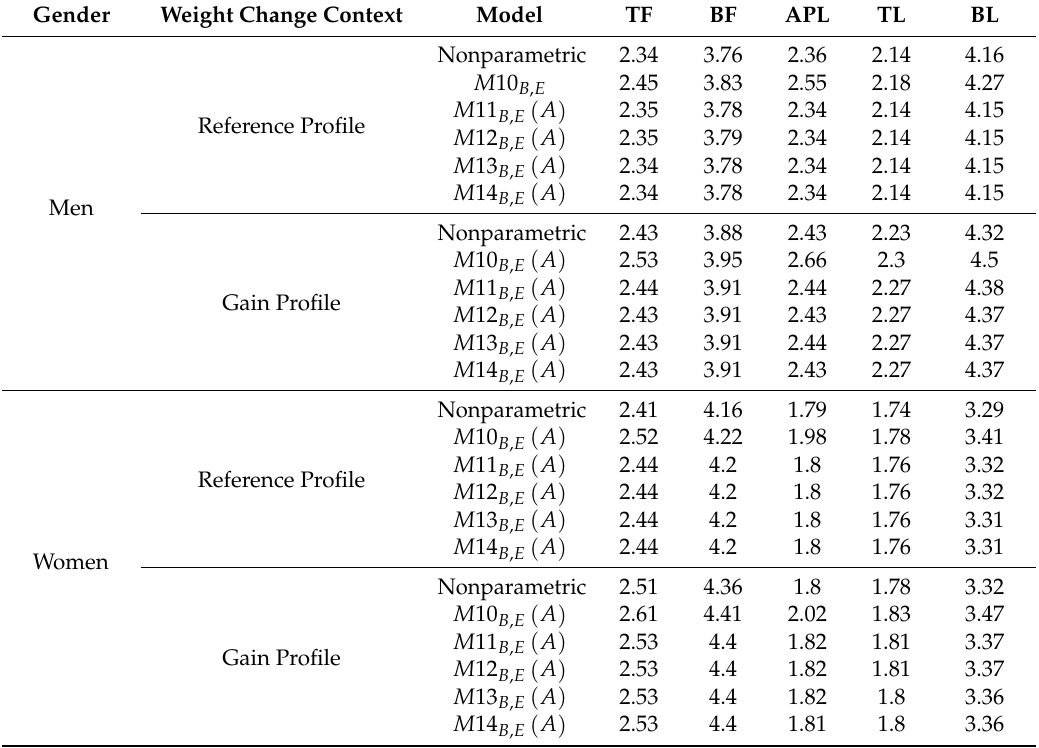
Table 7. For effect of ethnicity, standard error of the estimate (kg) of different models in men and women. In columns, the five segmental body compositions, in rows, the different models for two weight trend